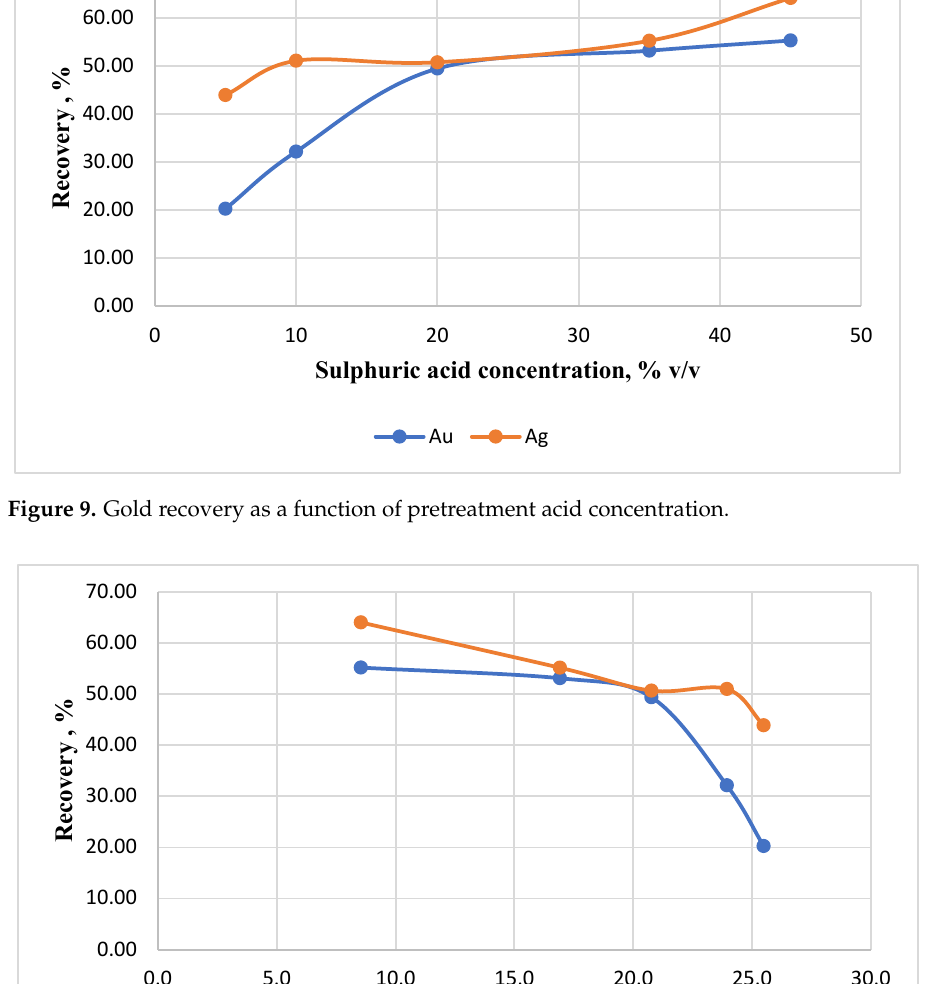
Figure 10. Relationship between remaining acid digested residue Fe and gold recovery.